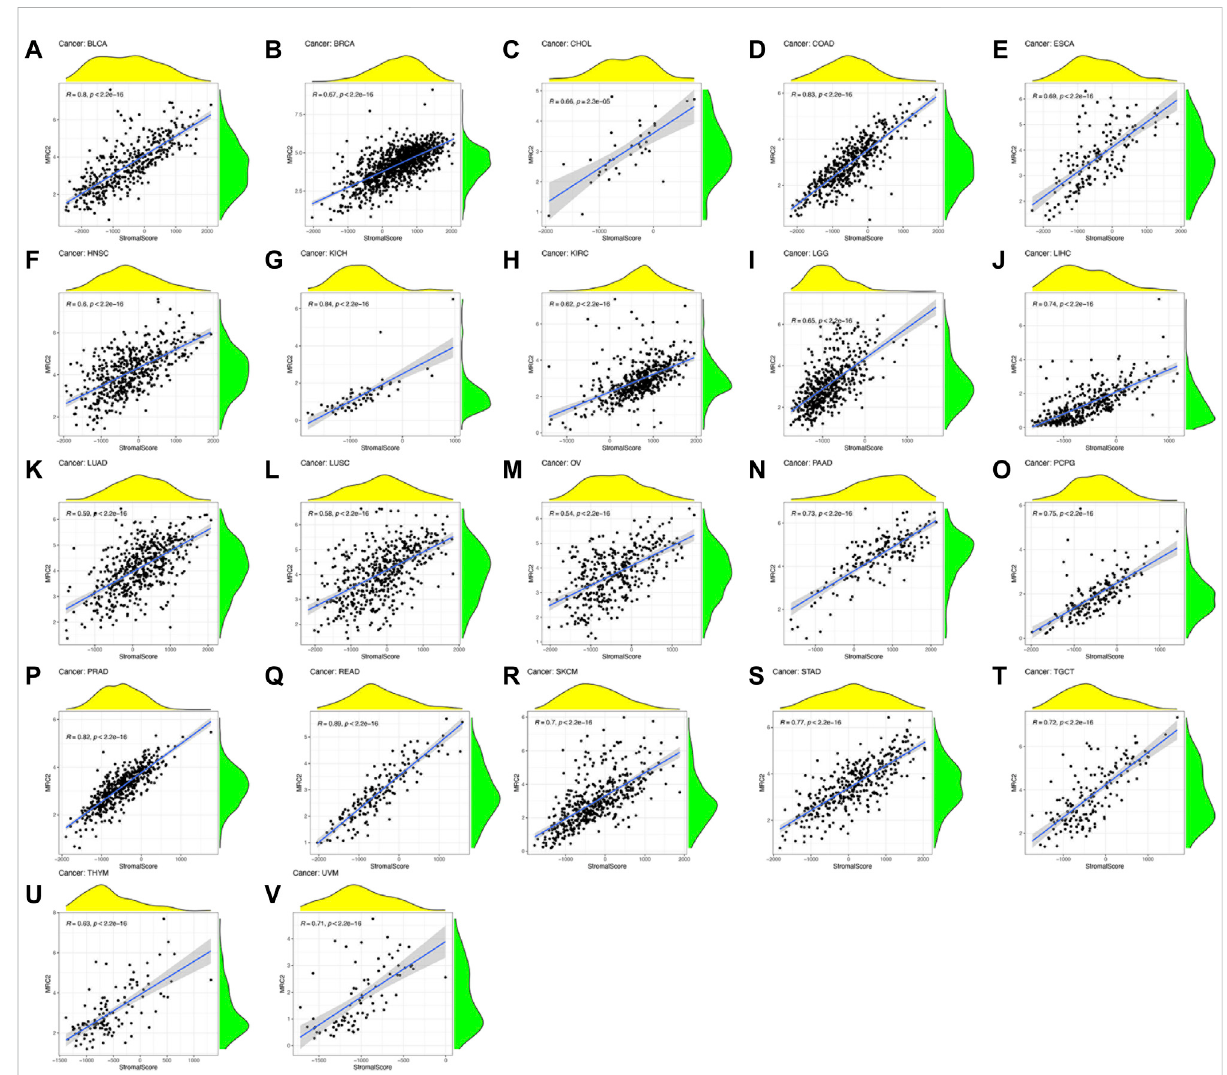
FIGURE 3 The correlation of MRC2 expression with Stromal Score. The correlation fi lter was set as p < 0.001 and |R| > 0.5 (A – V)